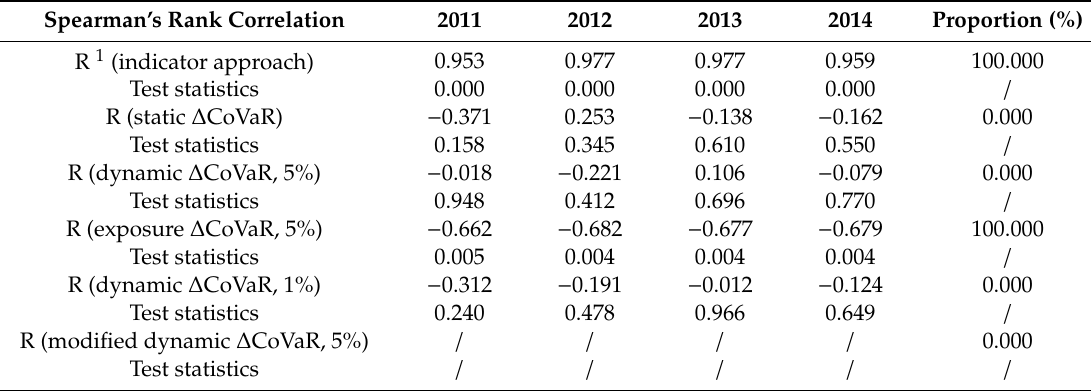
Table 6. The results of Spearman’s rank correlations.